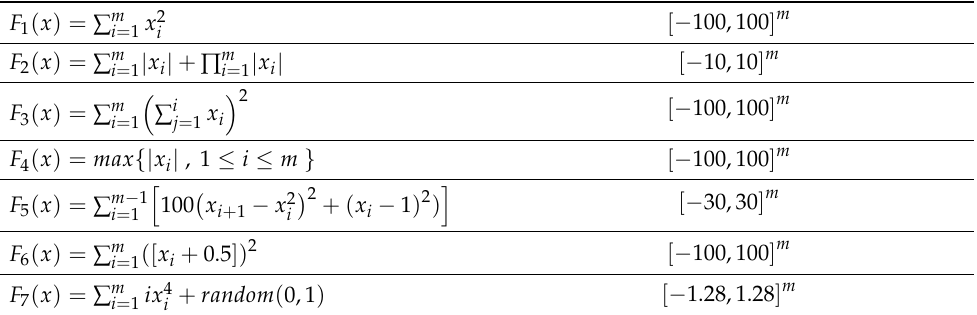
Table 2. Unimodal test functions.